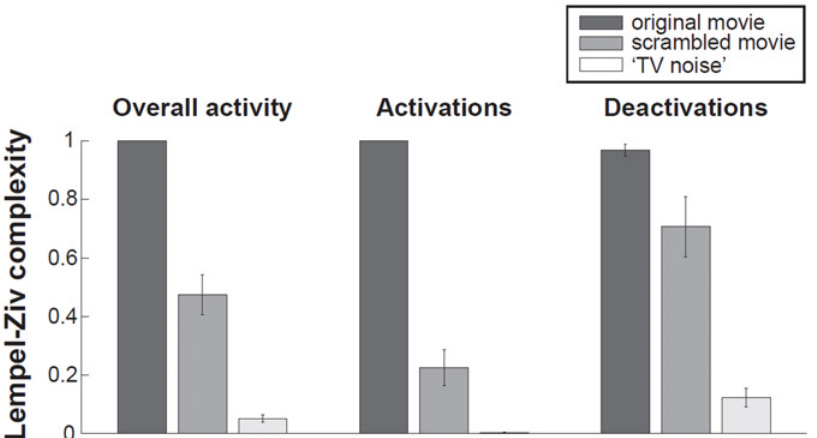
Fig 6. Group results for Lempel-ziv complexity analyses — comparison to the sequence mean. Lempel- Ziv complexity values for movie, scrambled movie, and 'TV noise'. Left panel: overall activations/ deactivations (F test) group values. Middle panel: complexity values for activations only (positive T test) Right panel: complexity values for deactivations only (negative T test). For display purposes, each subject ’ s Lempel-Ziv complexity was normalized by its individual maximum value across all conditions. Bar graphs show group mean and standard error of the mean in each